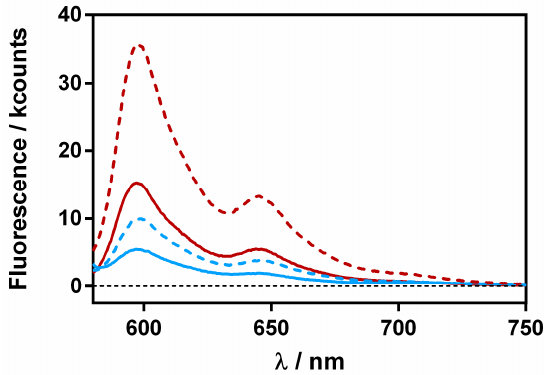
Figure 11. Fluorescence emission spectra of β LG-Hyp complex (60 µ M and 8 µ M, respectively) in the presence of 20 (red) and 40 (blue) µ M RA. The solid lines represent the complex in solution and the dashed ones after a 30-min incubation with S. aureus .